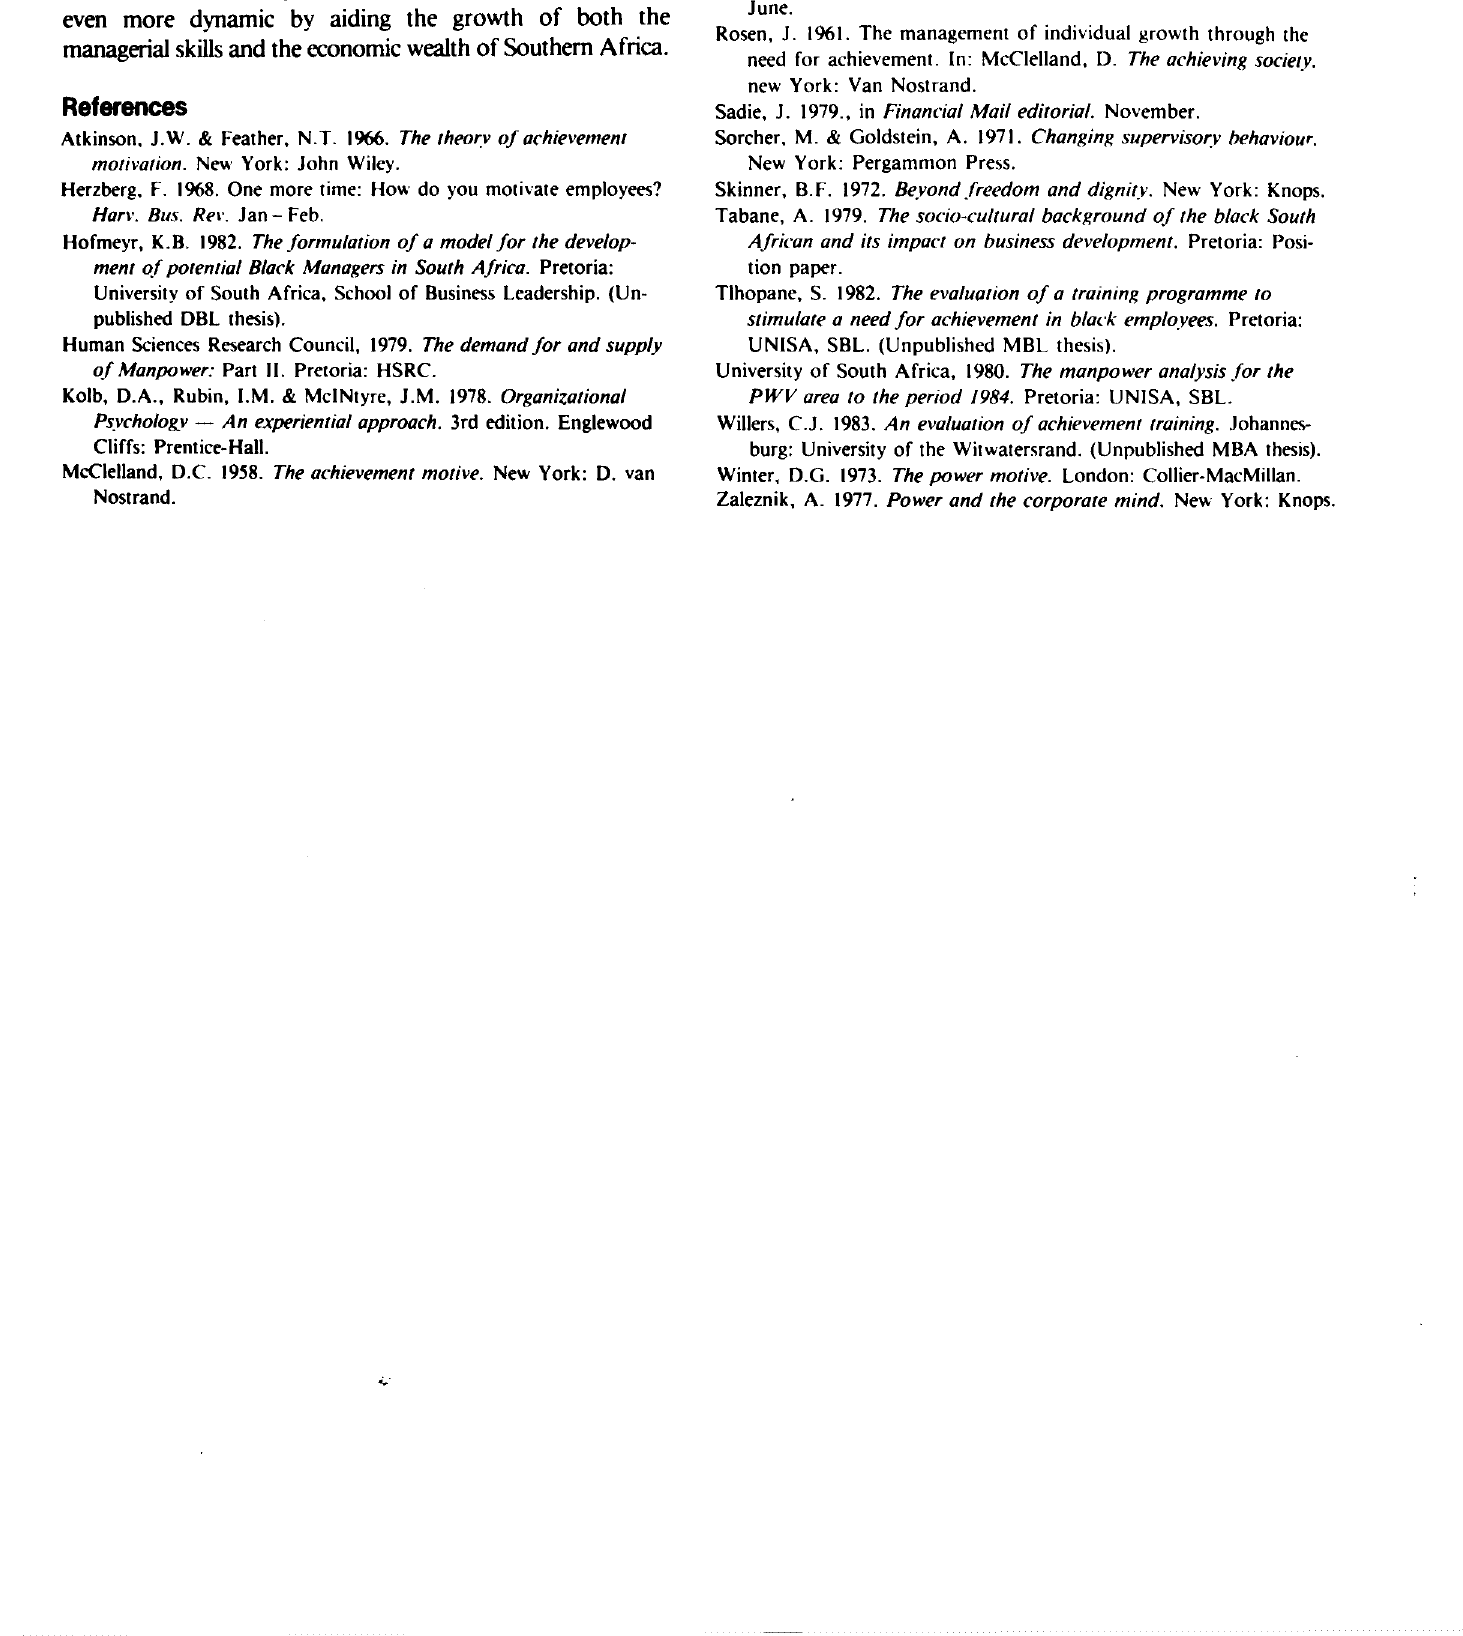
Tabane, A. 1979. The socio-cultural background of rhe block South African and ifs impocr on business development. Pretoria: Posi tion